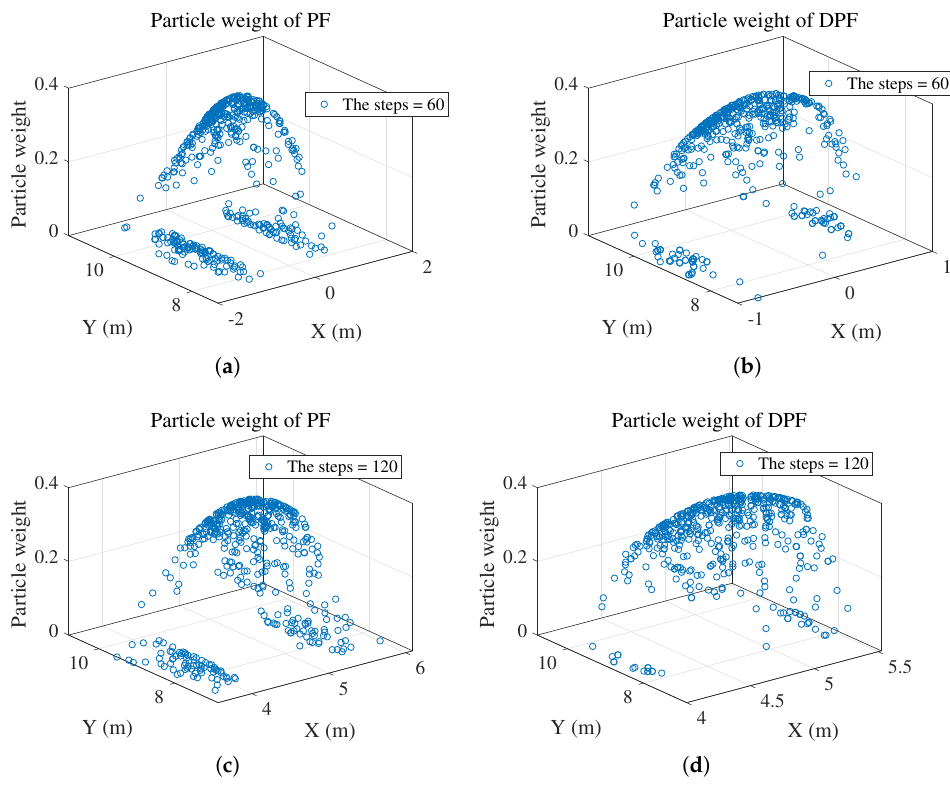
Figure 6. Particle weight experiment. ( a ) The 60th step. ( b ) The 60th step. ( c ) The 120th step. ( d ) The 120th